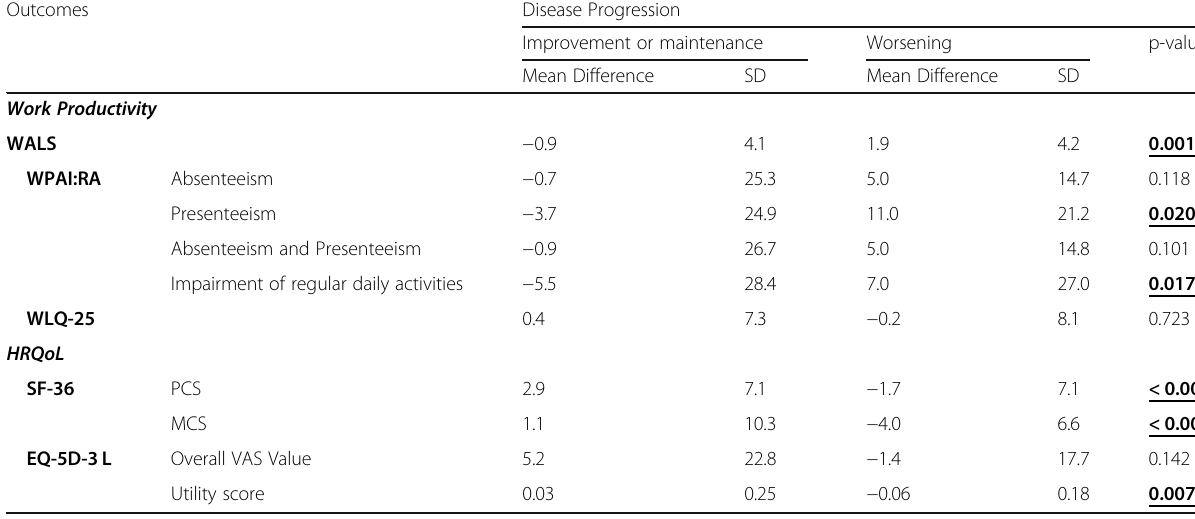
Table 5 Comparison between differences in work productivity and HRQoL scores and disease progression from the first to the last study visit